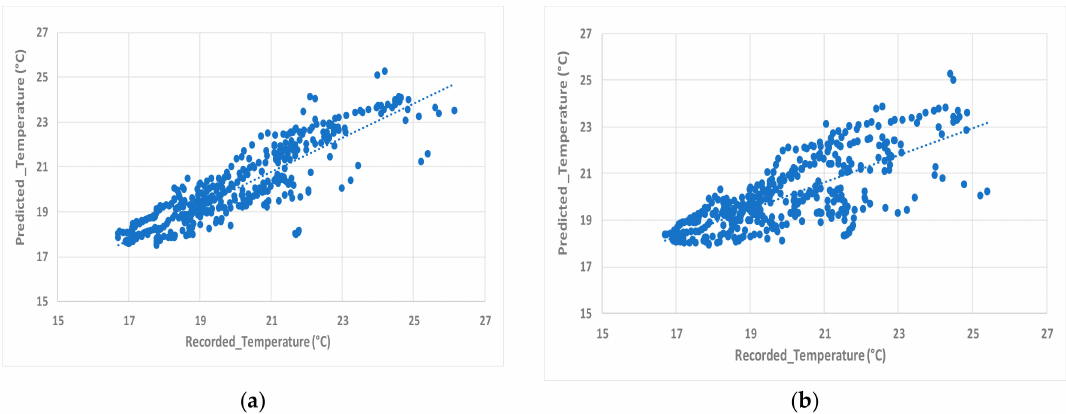
Figure 9. Predicted facade temperature with the recorded facade temperature (input parameter = outdoor temperature): ( a ) prediction for 2 h; and ( b ) prediction for 4 h.